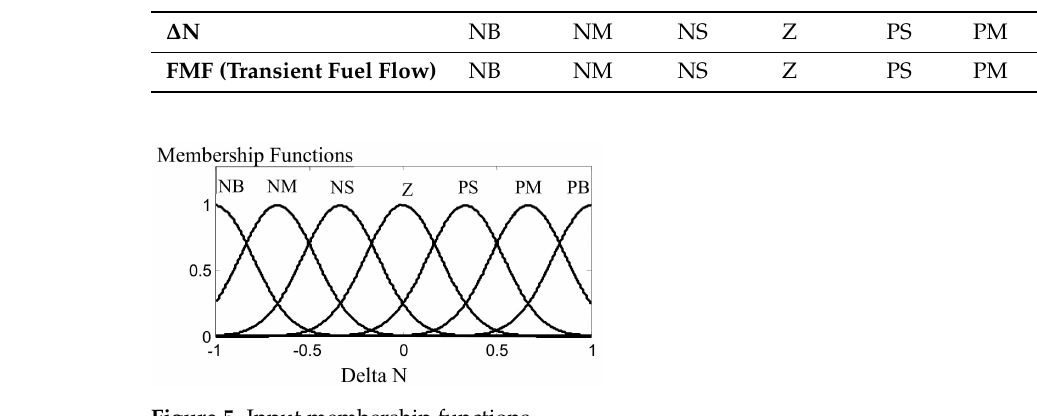
Table 4. Fuzzy rules for PLA control loop.